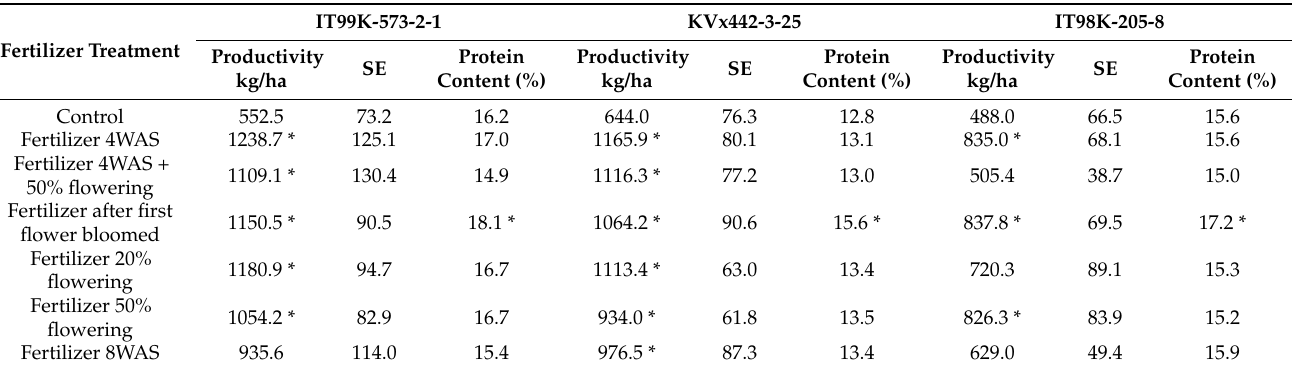
Table 4. Productivity and protein content under different timings of fertilizer